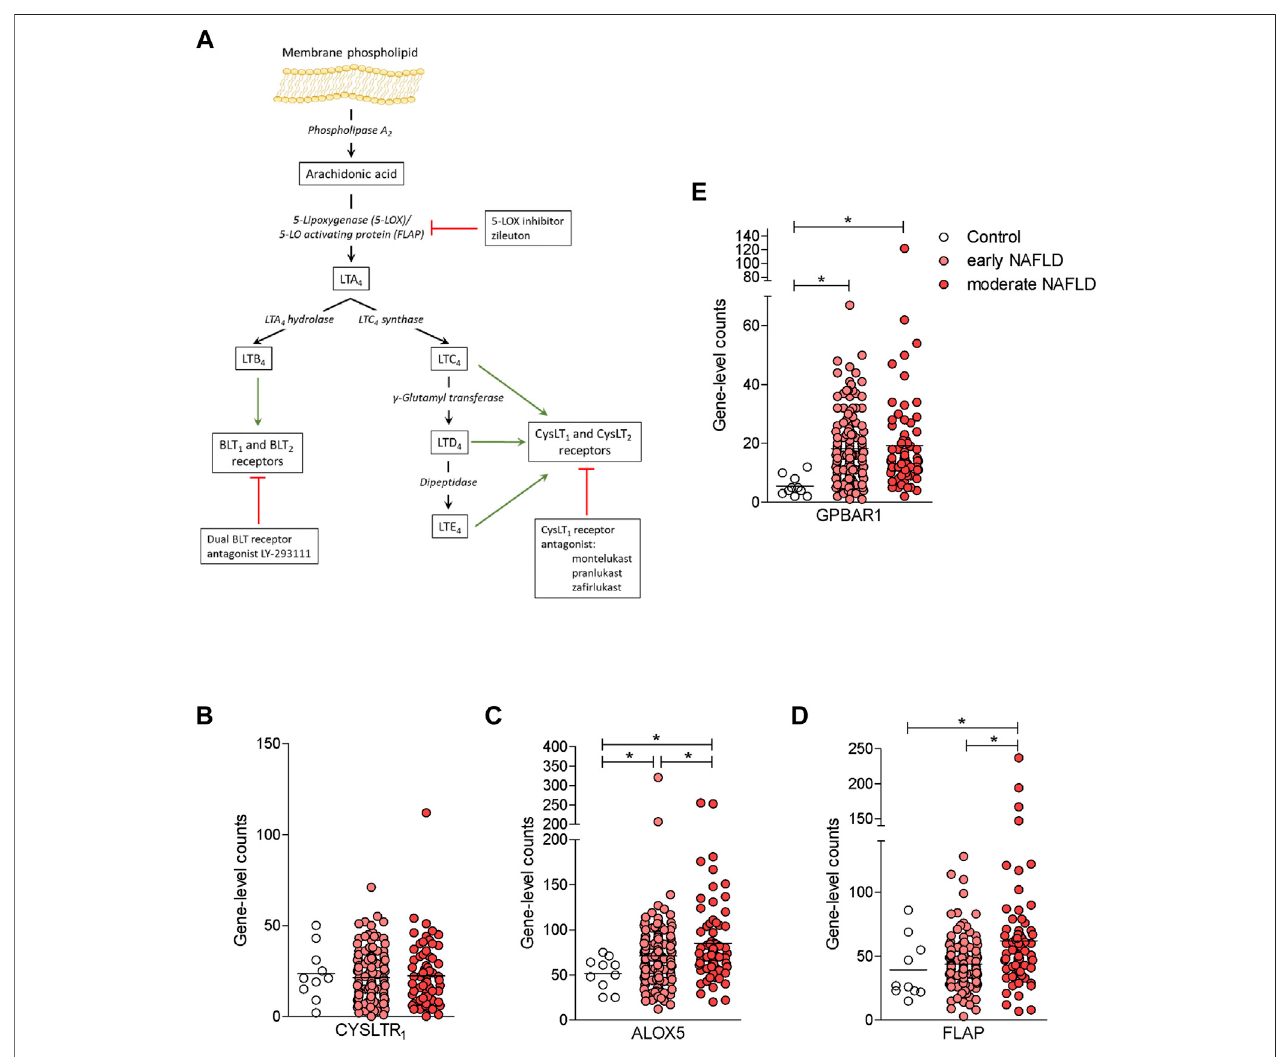
FIGURE 4 | The synthesis of leukotrienes isupregulated in the liver ofNAFLD patients. (A) Leukotriene synthesis pathway indicating the enzymes that are involved ineach stepofsynthesis. (B-E) RNA-seq analysisofliverbiopsysamplesfromGSE135251repository ofcontrol, earlyNAFLD,and moderateNAFLDpatients.Each dot represents a patient. Gene pro fi le expression of (B) CYSLT 1 R, (C) ALOX5, (D) FLAP, and (E) GPBAR1. * p < 0.05.